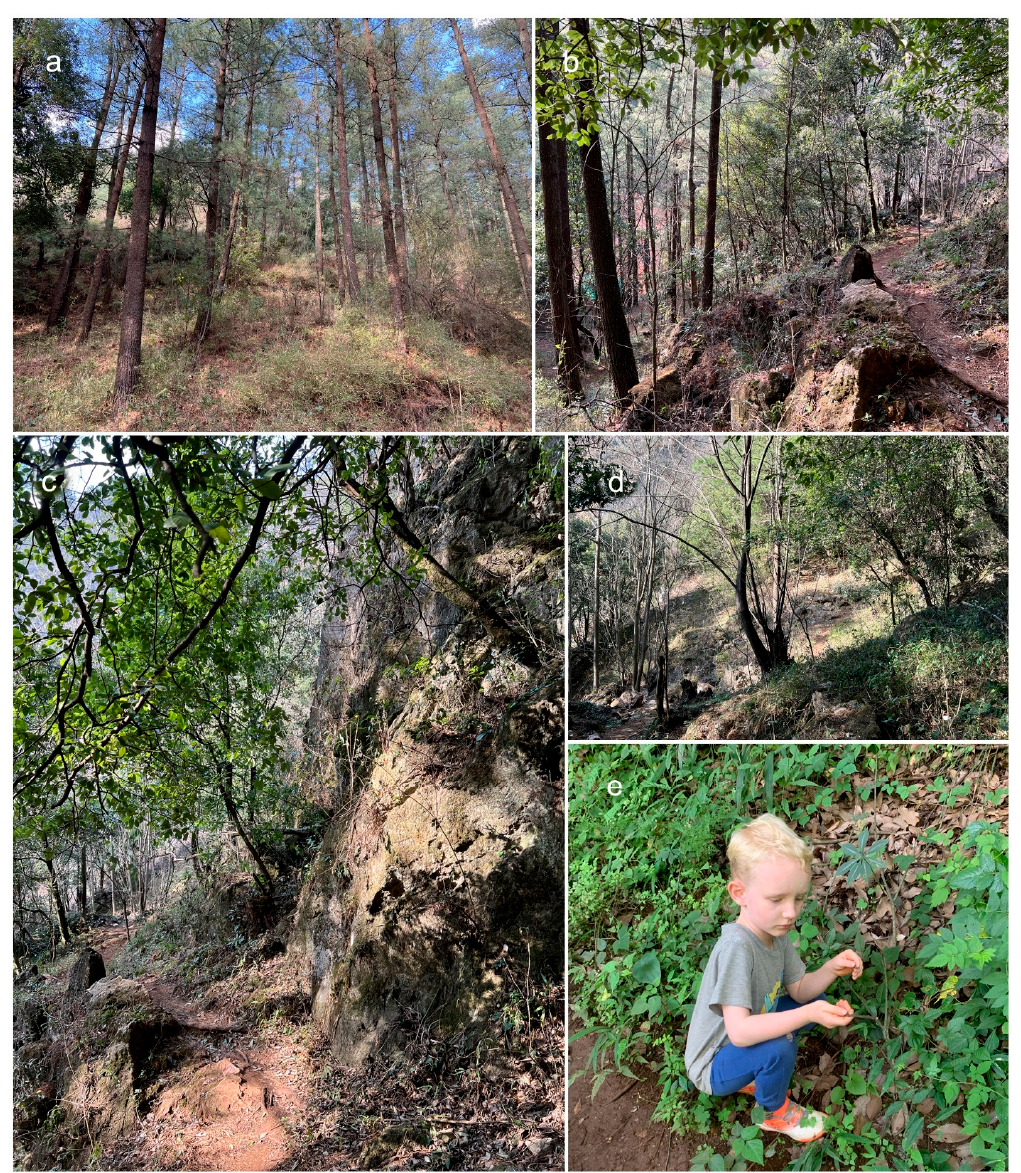
Figure 1. Habitat. ( a – d ) Mixed forest (predominantly Fagaceae and Pinus spp., with Pinus yunnanensis being the most abundant tree species); ( e )